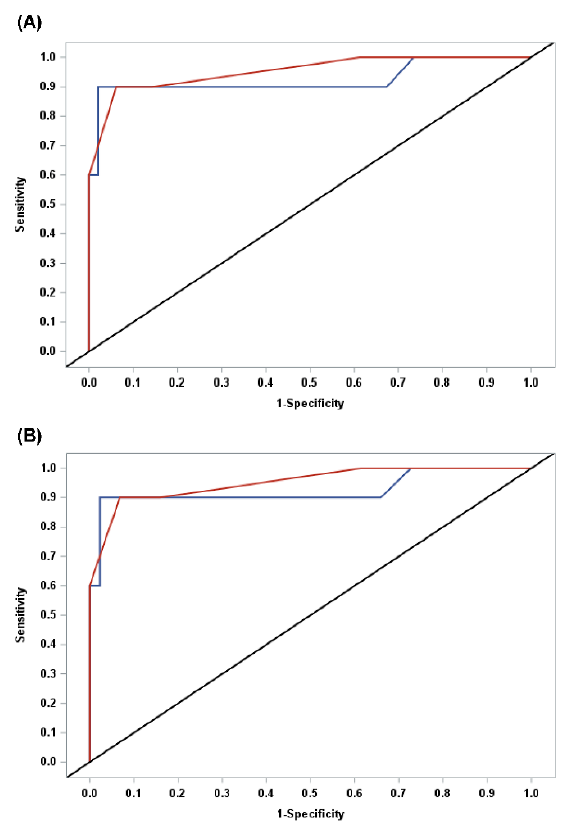
Figure 2. Receiver operating characteristic (ROC) curves of overall malignancy risk in the ADNEX (assessment of different neoplasias in the adnexa) model (blue) and subjective assessment (red) in ( A ) all participants and ( B ) surgical group.